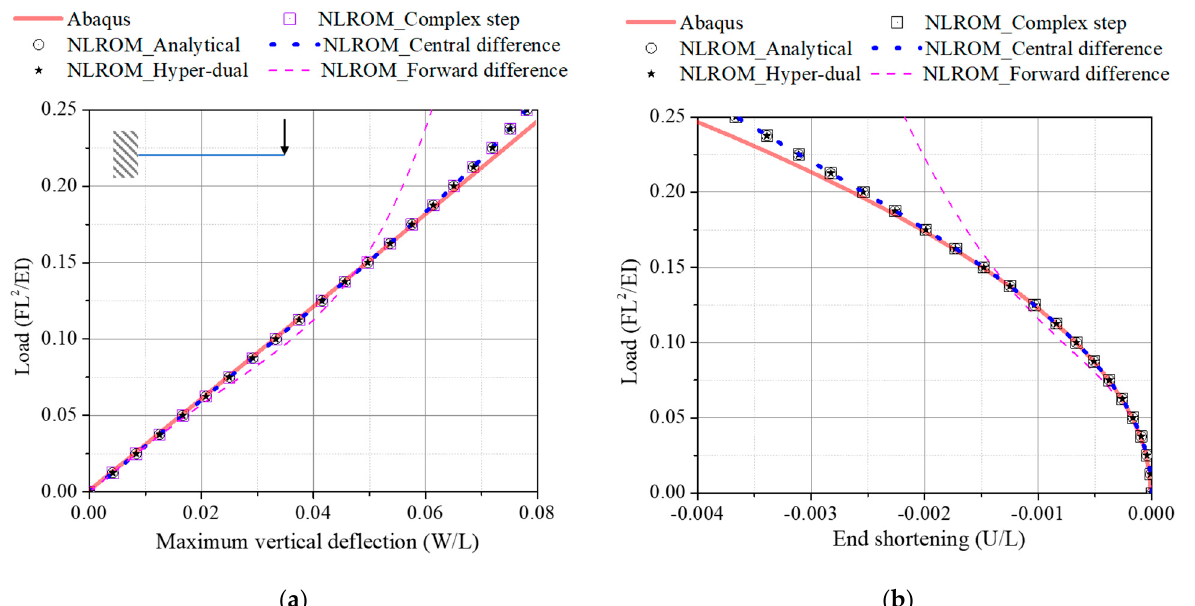
Figure 12. Static displacements at the free end of cantilever beams obtained from Abaqus and fi fth- order NLROMs: ( a ) Vertical de fl ection; ( b ) End shortening.